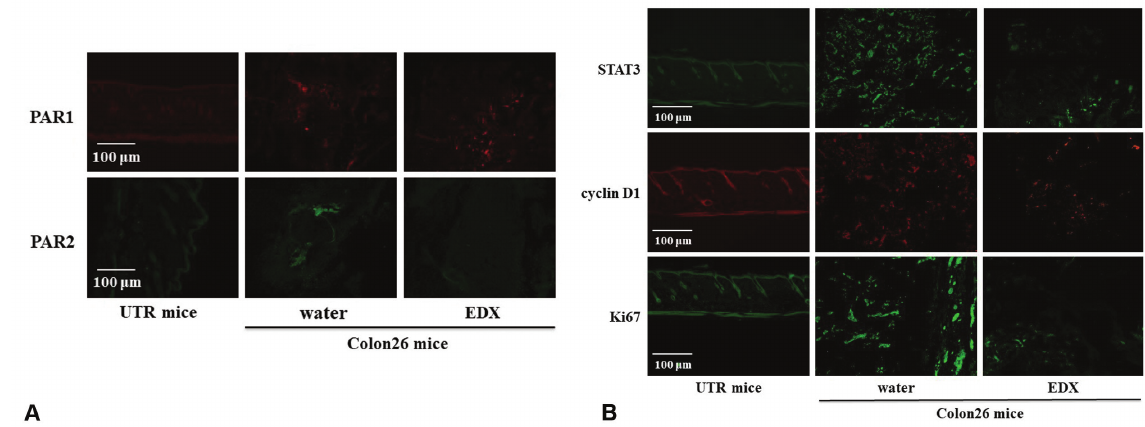
Fig. 4 ( A ) Immuno fl uorescence data for PAR1 and PAR2 expression in the normal thigh tissues of untreated (UTR) mice and tumor tissues of the water-treated group or edoxaban (EDX) (10mg/kg/d)-treated group of Colon26-inoculated mice on day 21. ( B ) Immuno fl uorescence data for STAT3, cyclin D1, and Ki67 expression in normal thigh tissues of untreated (UTR) mice and tumor tissues of the water-treated group or EDX- treated group of Colon26-inoculated mice on day 21. TH Open Vol. 7 No. 1/2023 © 2023. The